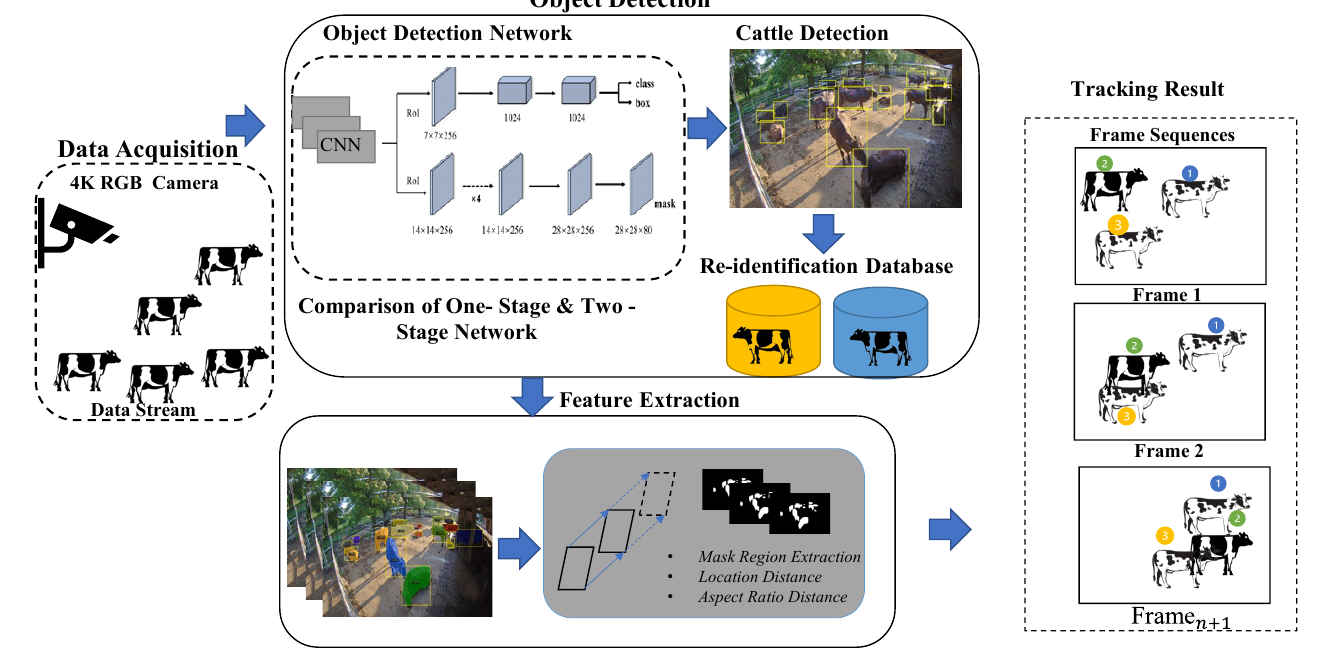
Figure 2. The complete steps of the proposed system.